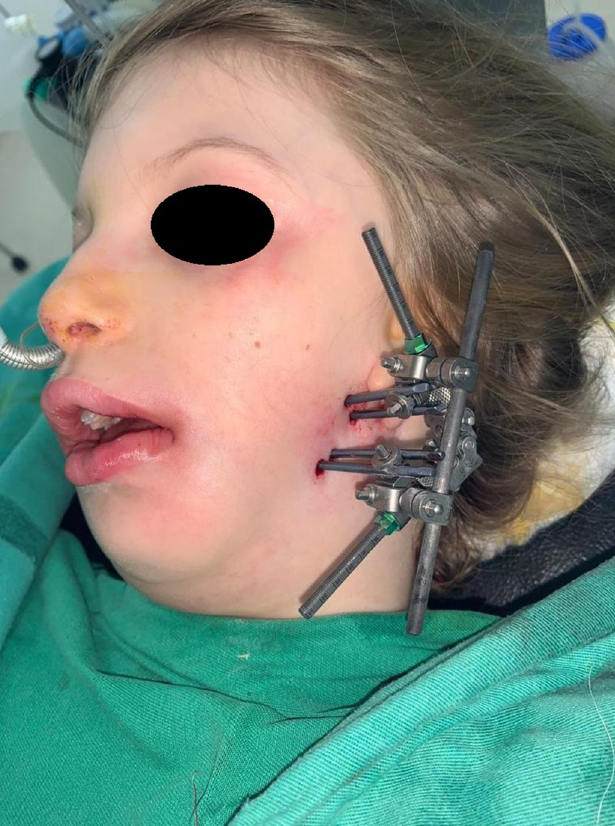
Fig. 6. The patient still under general anesthesia, with the distractor